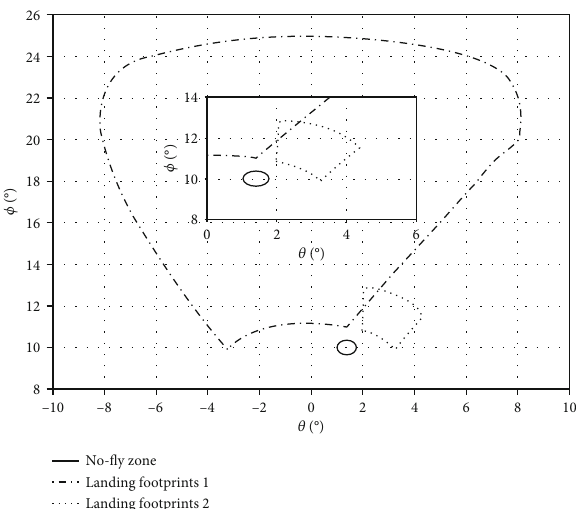
Figure 29: Landing footprints for Case 2.